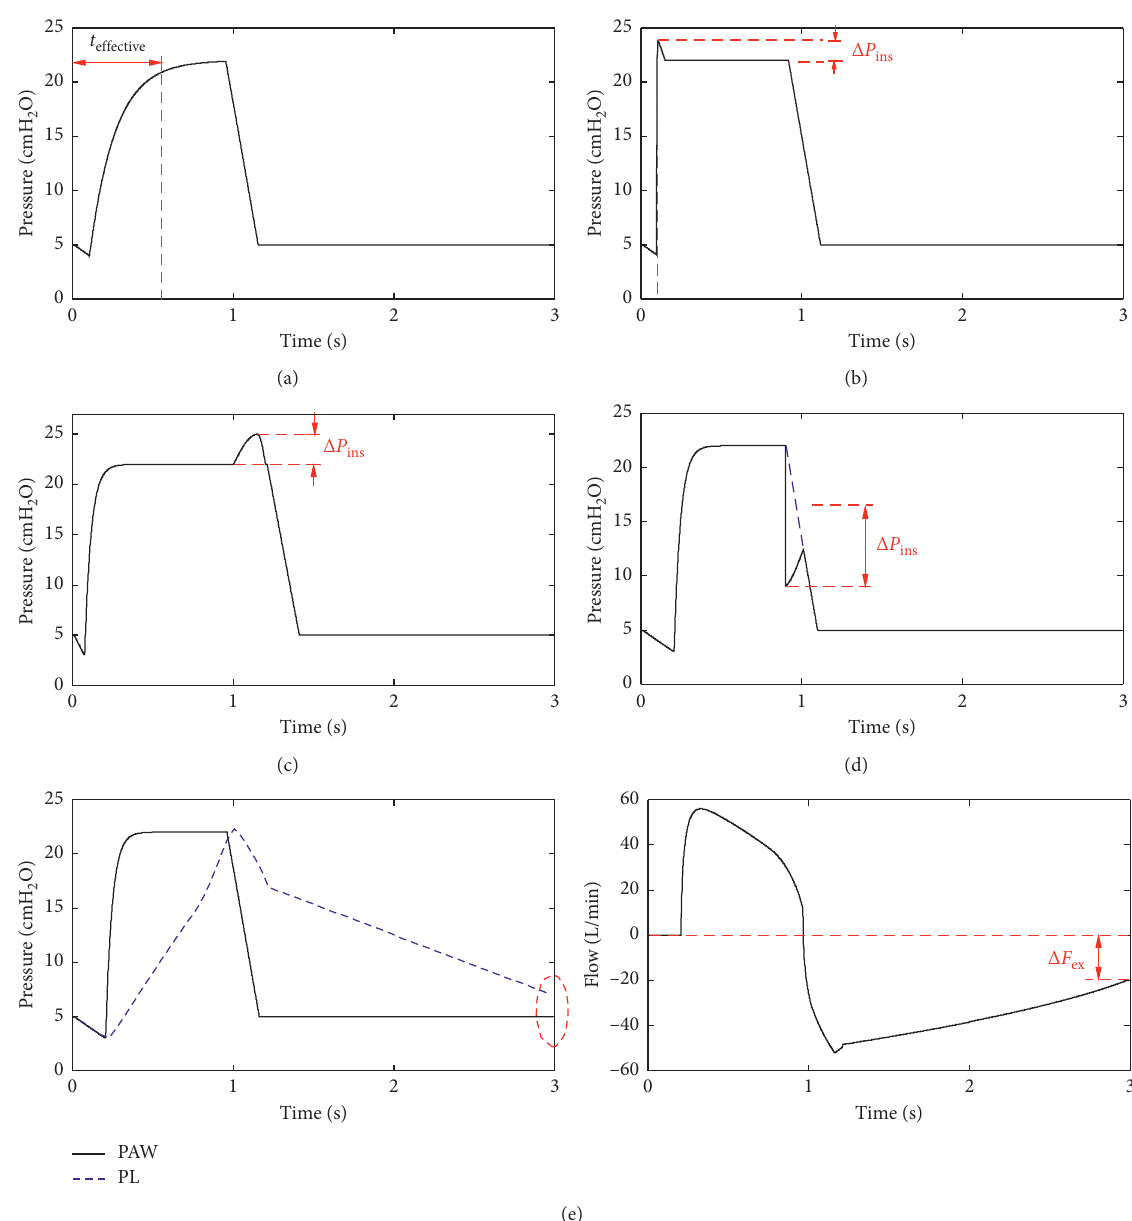
Figure 17: Evaluating patient-ventilator synchrony of the breathing cycles with asynchrony